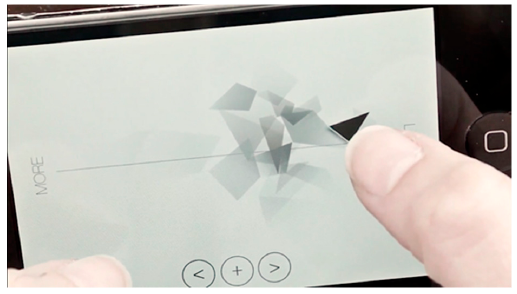
Figure 10. The graphical interface of [Y]our Perspective inspired by the Conflict Spectrum.